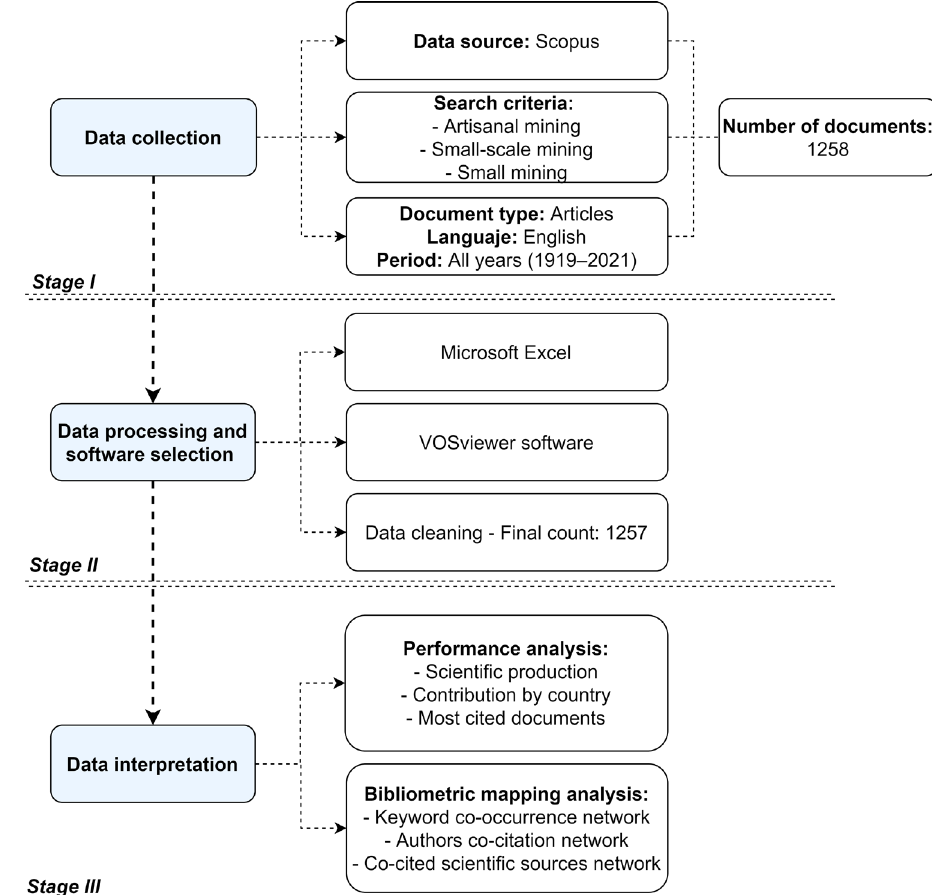
Figure 2. General methodological scheme of the study.